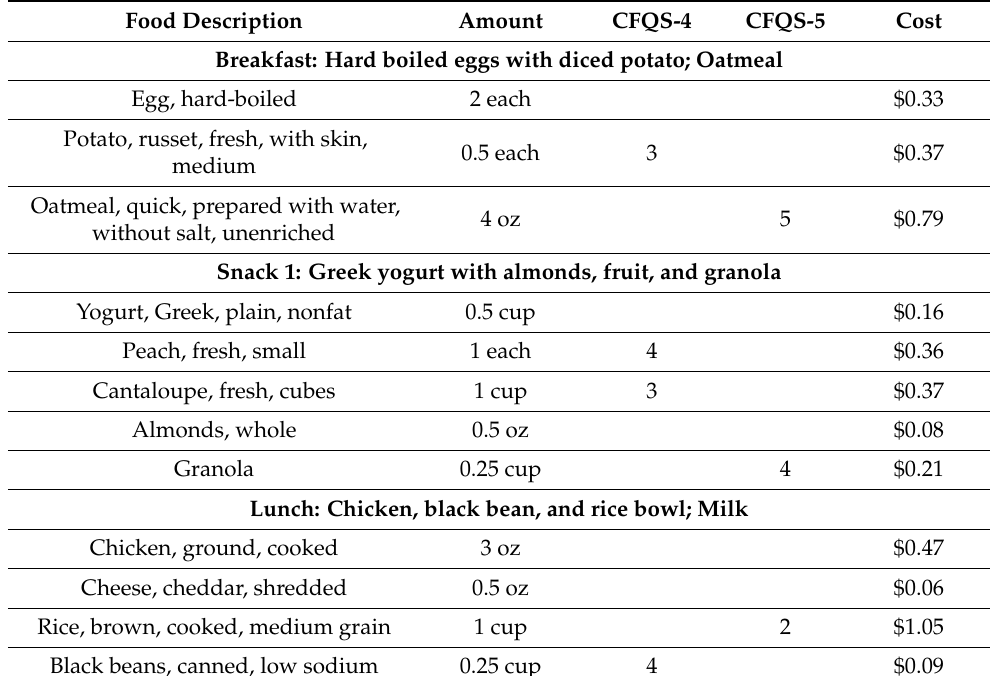
Table 9. Sample Daily Menu: Thrifty Food